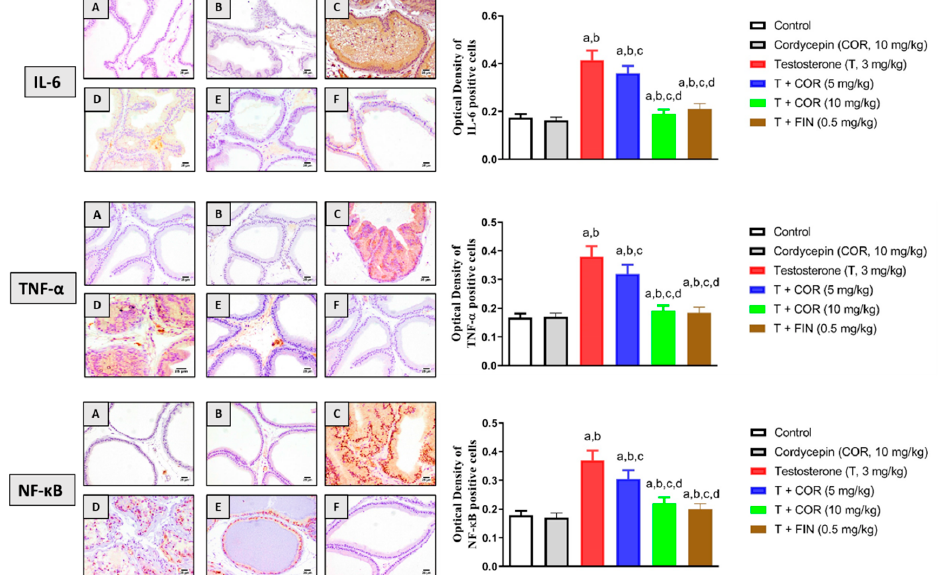
Figure 3. Effect of cordycepin on the expression of IL-6, TNF- α , and NF- κ B as determined by immunohistochemistry in prostatic tissues of testosterone-treated rats. ( A ) Control, ( B ) cordycepin, ( C ) testosterone, ( D ) testosterone + cordycepin 5 mg/kg, ( E ) testosterone + cordycepin 10 mg/kg, and ( F ) testosterone + finasteride. Data ( n = 6) presented in the bar charts are mean ± SD. COR = cordycepin, T = testosterone, FIN = finasteride. a, b, c, or d: statistically different from control, cordycepin, testosterone, or T + COR (5 mg/kg), respectively ( p < 0.05).